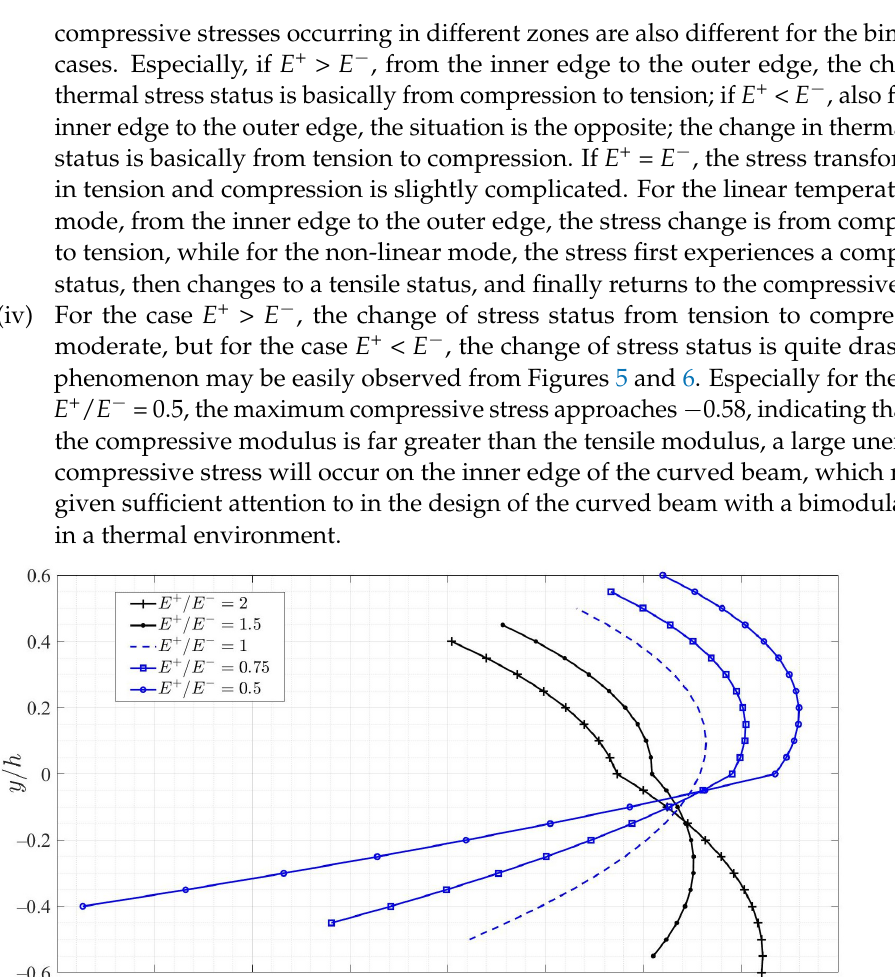
Figure 6. Thermal stress variation along thickness direction under non-linear temperature rise.